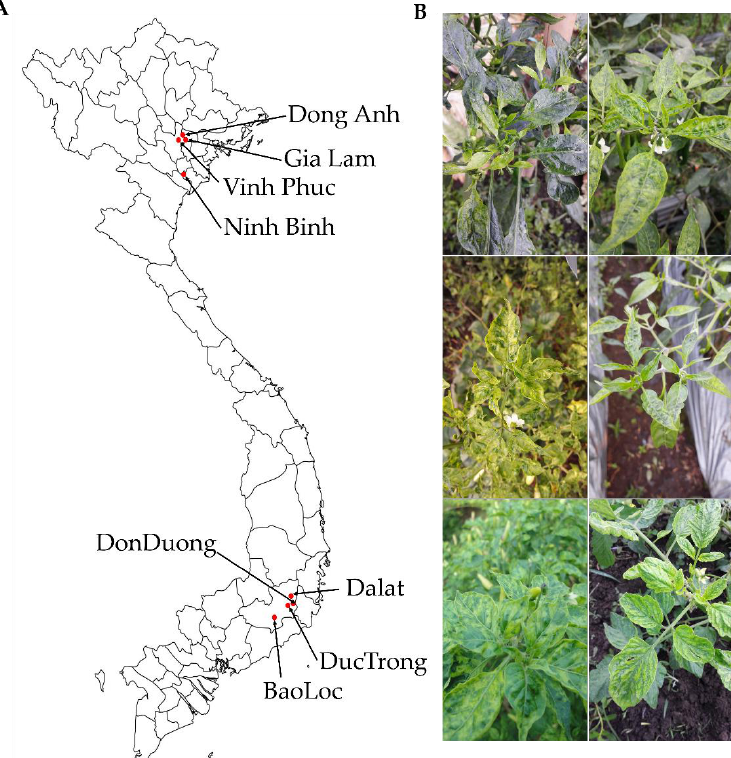
Figure 1. Locations of pepper and tomato sample collection ( A ) and typical symptoms observed in collected samples ( B ).